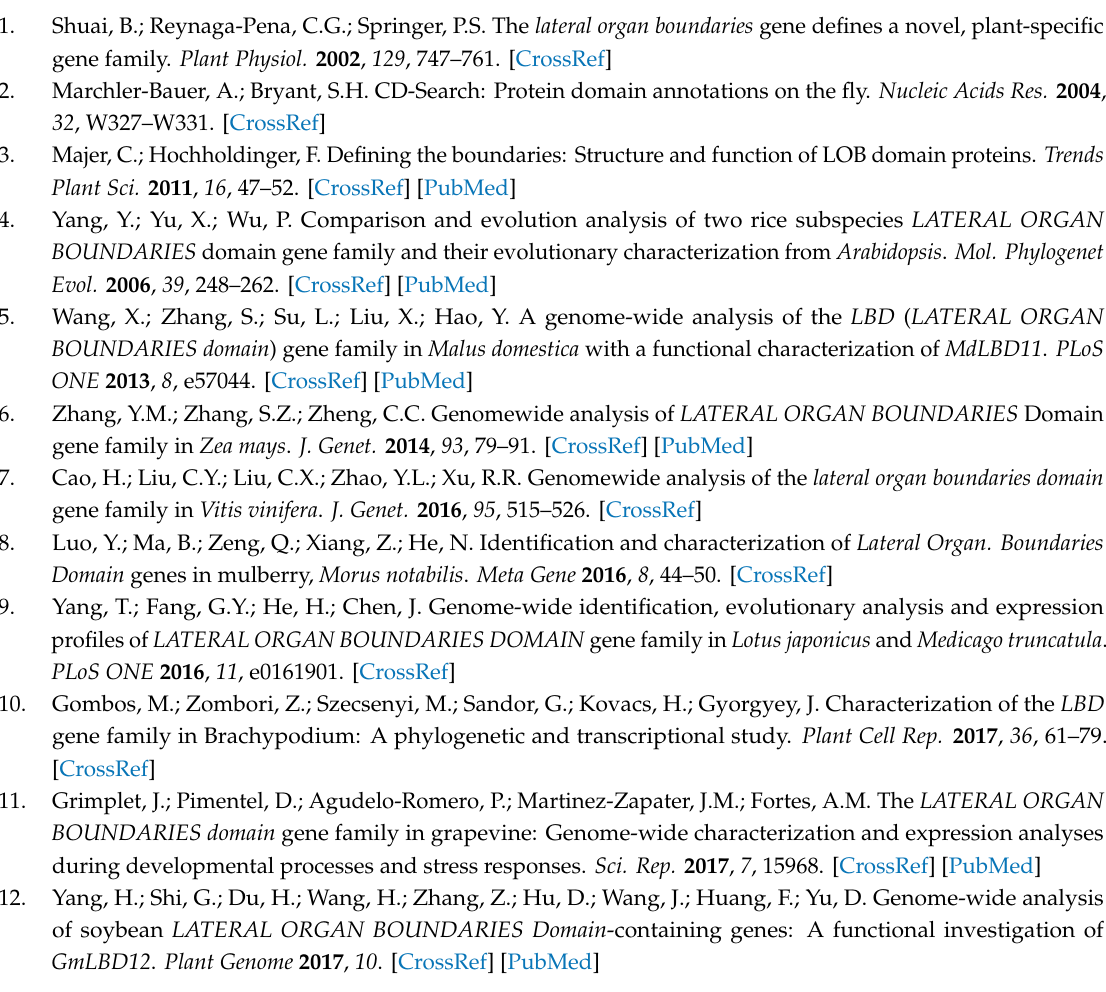
Figure S1. Multiple sequence alignment of LOB domains in BnLBD proteins using ClustalX, Figure S2. Conserved protein motifs BnLBDs family. The bit score exhibits the information content for each position in the sequence, Figure S3. Ka / Ks value and divergence time distribution of LBD genes. (a). B. napus - B. napus . (b) B. napus - B. rapa (c). B. napus - B. oleracea . (d). B. napus - A. thaliana , Table S1. The primers used in this study, Table S2. The